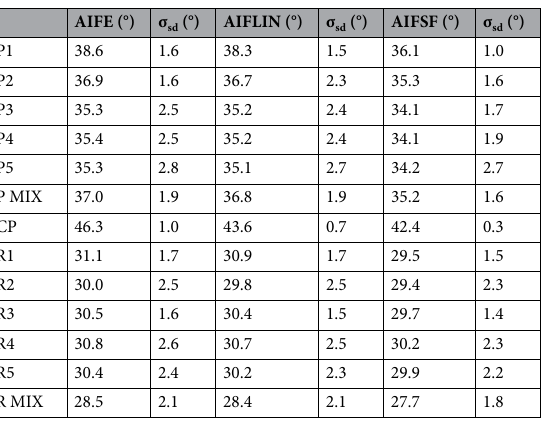
Table 5. Internal friction (AIFE, AIFLIN and AIFSF) with standard deviation.